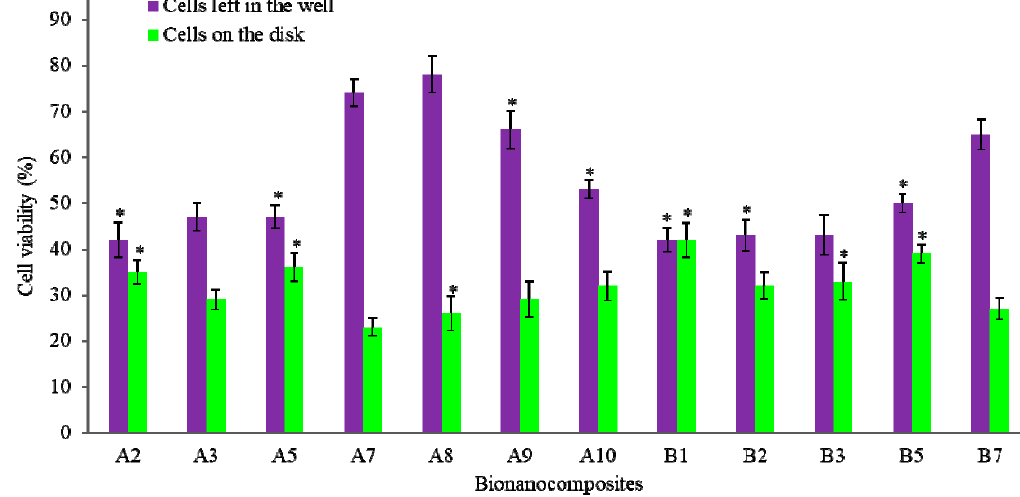
Figure 4. Cell viability results of PEEK and its nanocomposites. * represents p < 0.05.